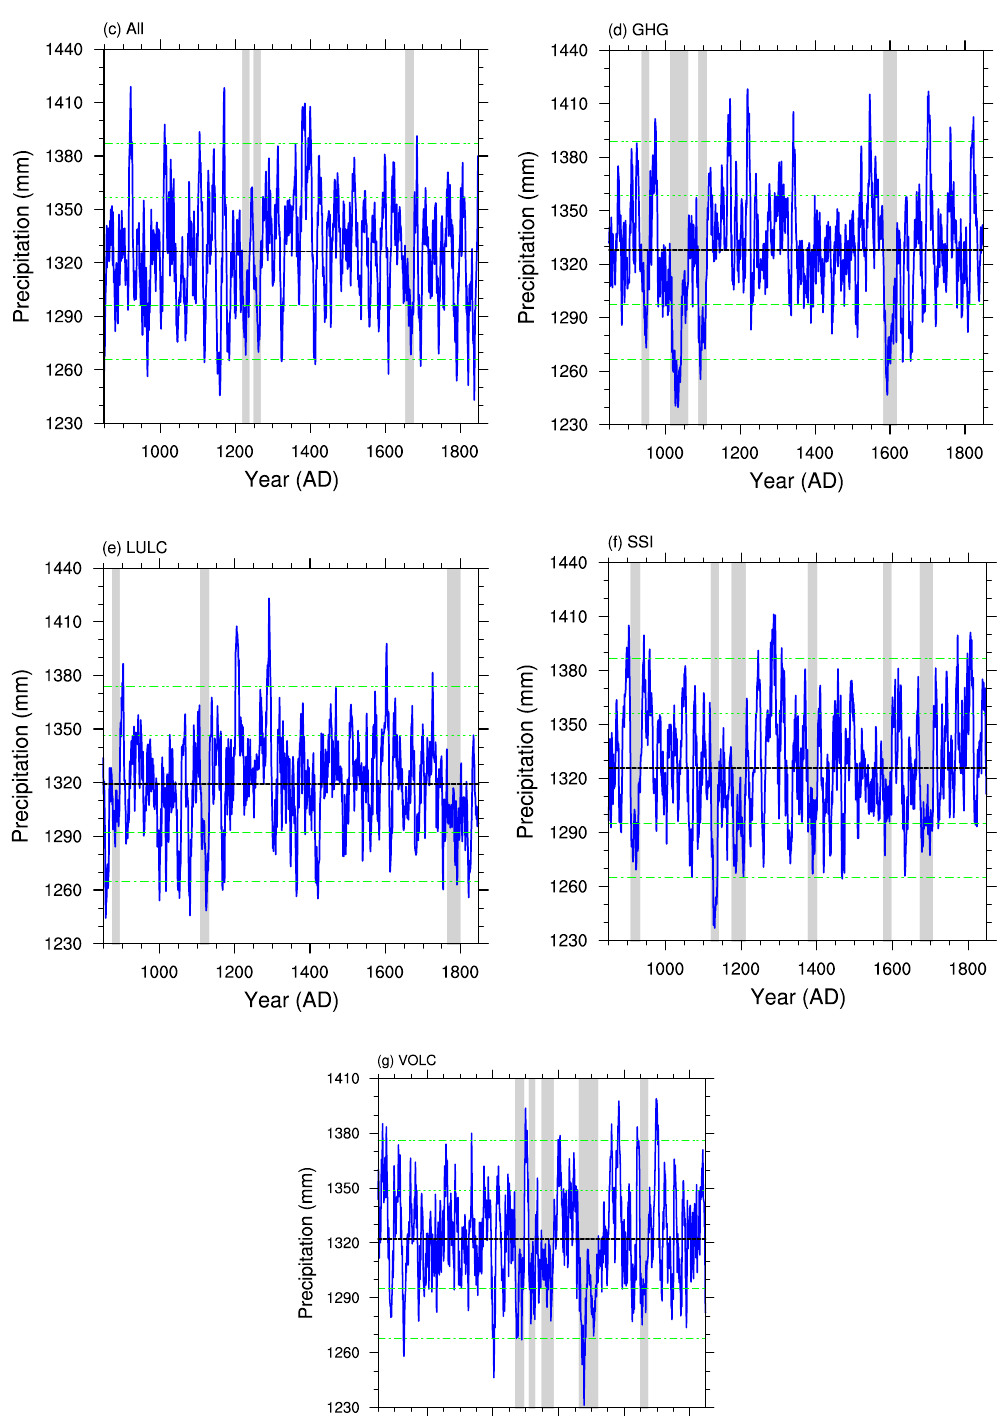
Figure 1. The time series of the reconstructed dry/wet index ( a ), simulated precipitation averaged over eastern China from the control (CTRL) run ( b , unit: mm/year), the first member of the all-forcing (ALL) experiment ( c , unit: mm/year), greenhouse gas (GHGs) experiment ( d , unit: mm/year), land use and land cover (LULC) experiment ( e , unit: mm/year), spectral solar irradiance (SSI) experiment ( f , unit: mm/year), and volcanic eruption (VOLC) experiment ( g , unit: mm/year) with megadroughts highlighted in gray. The black solid lines indicate the mean values. The green dashed lines indicate the ±1 and ±2 standard deviations.